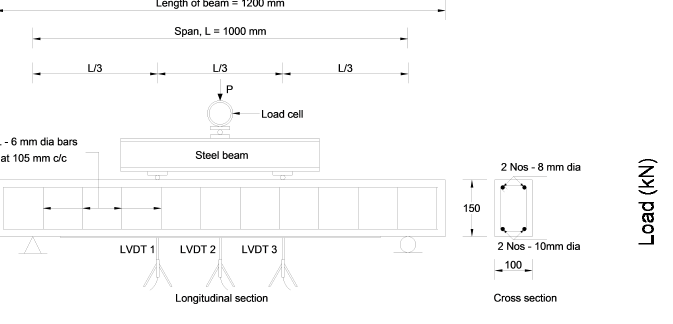
Figure 5: Load Setup and reinforcement details